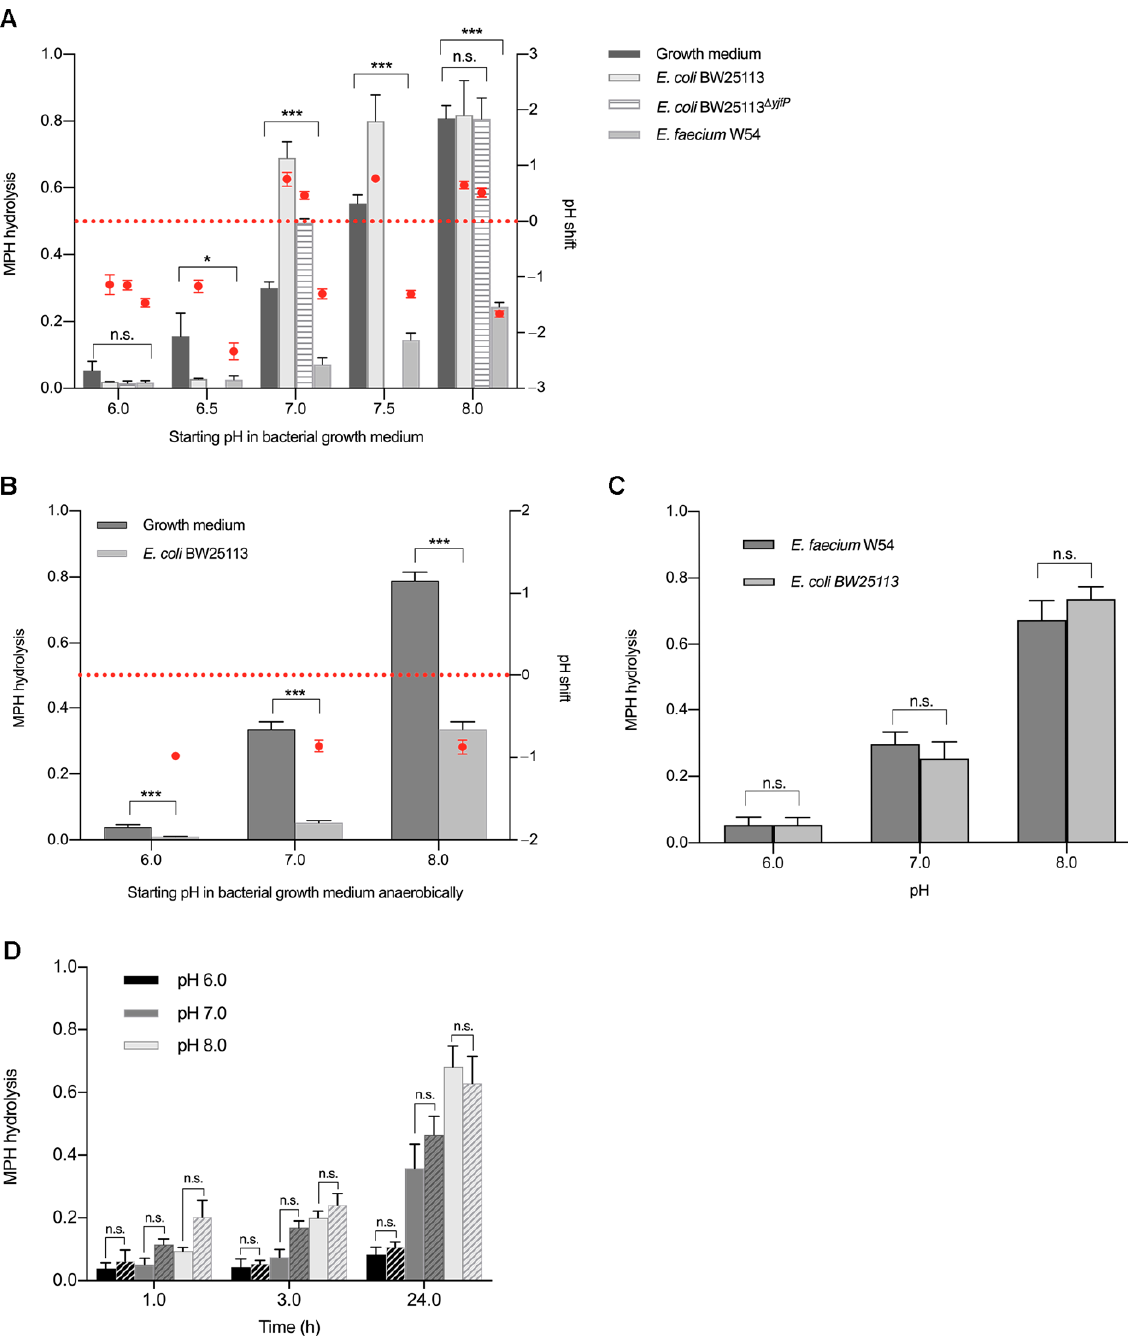
Figure 3. Effect of pH on methylphenidate hydrolysis in the presence and absence of bacterial esterases. Methylphenidate hydrolysis at different starting pH in ( A ) bacterial growth medium, E. coli BW25113, E. coli BW25113 Δ yjfP and E. faecium W54 pure cultures, ( B ) E. coli BW25113 pure cultures anaerobically, ( C ) E. coli BW25113 and E. faecium W54 bacterial supernatants and ( D ) E. coli BW25113 cell lysates (solid bars) and phosphate buffer control (striped bars). Methylphenidate hydrolysis quantified in ng/µL and normalized to d10-ritalinic acid (left y -axis; grey bars) and pH changes during bacterial growth are shown as pH shift after 24 h (red dots; right y -axis). Error bars represent SD ( n = 3).* p < 0.05, *** p < 0.001